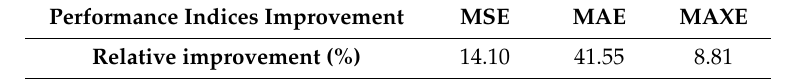
Table 8. Relative performance improvement of the SMO-based estimator over the phasor diagram based estimator during dynamic disturbances of active power for generator operating point P = 0.89, Q = 0.41 ind.